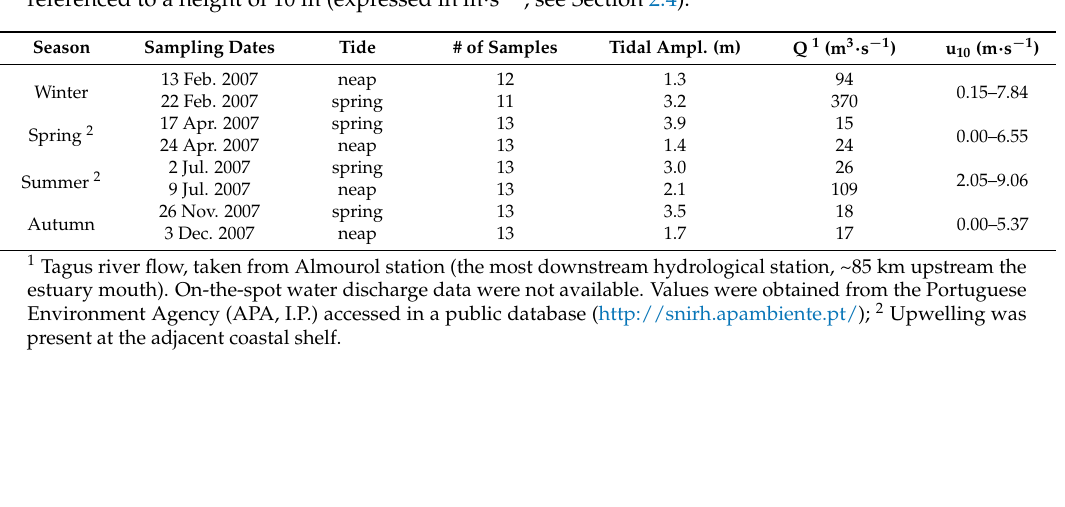
Table 1. Sampling dates and ranges of hydrologic and wind data recorded for each sampling period in the Tagus estuary fixed station during 2007. Q represents Tagus river flow and u 10 the wind speed referenced to a height of 10 m (expressed in m ∙ s − 1 , see Section 2.4).